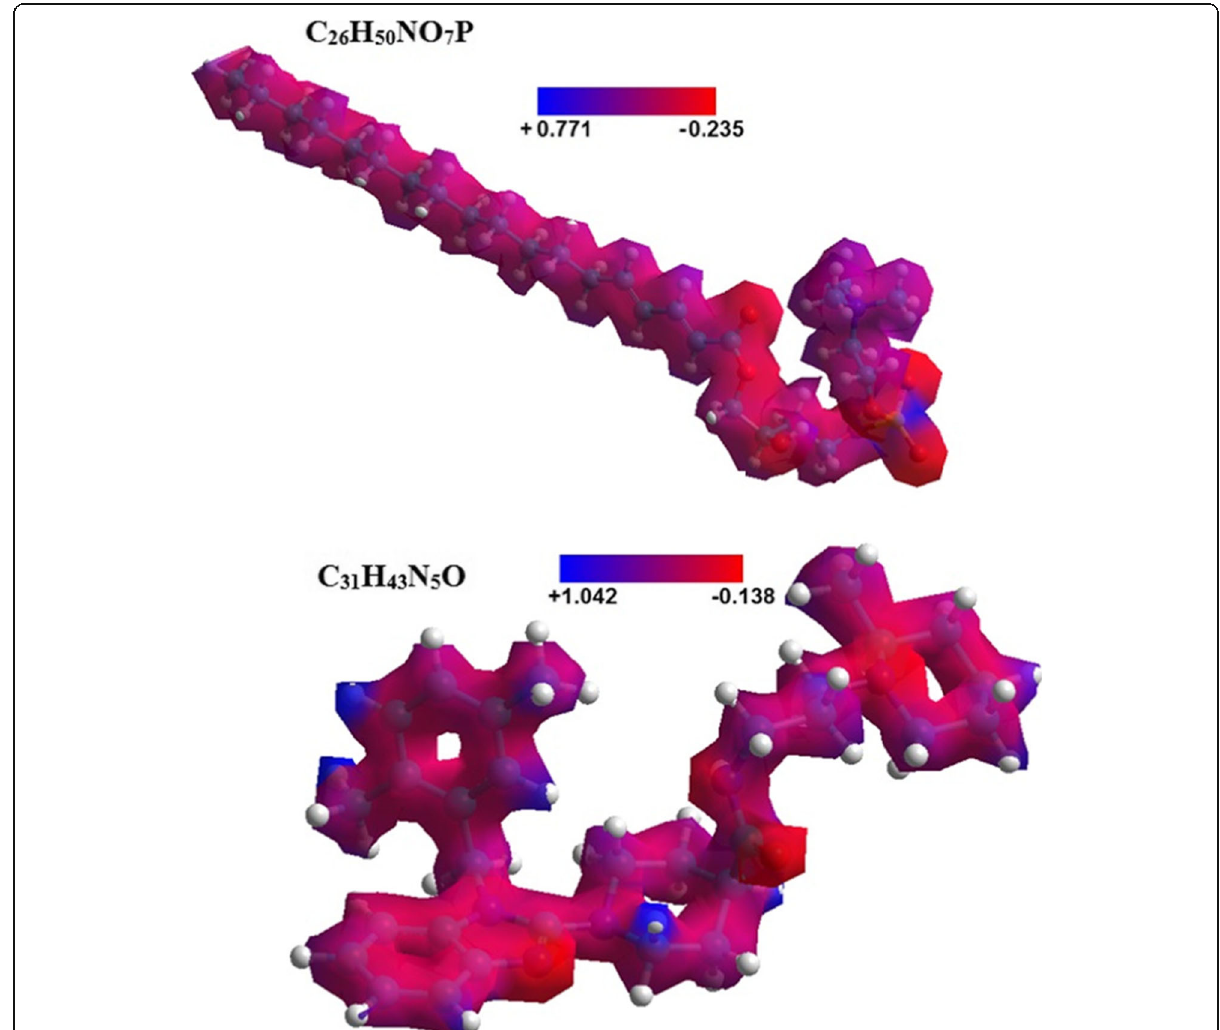
Fig. 16 Electrostatic potential maps of C 26 H 50 NO 7 P and C 31 H 43 N 5